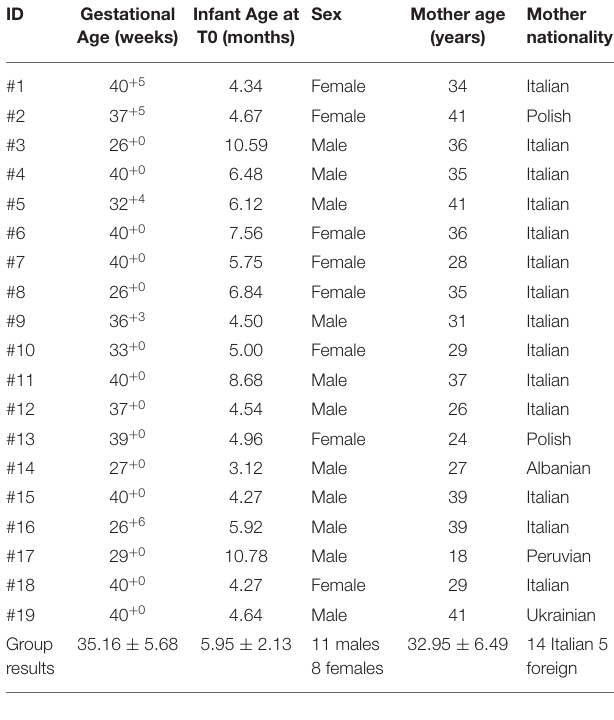
TABLE 2 | Sample characteristics.